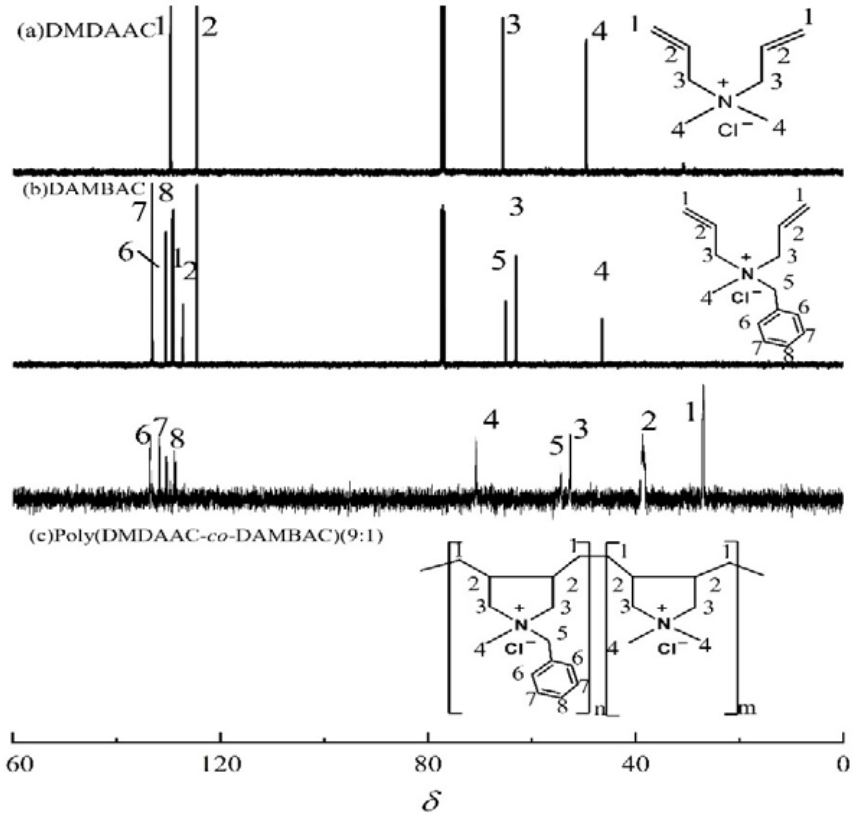
Figure 7. 13 C NMR spectra of DMDAAC ( a ), DAMBAC ( b ), and poly (DMDAAC ‐ co ‐ DAMBAC) (9:1) ( c ).